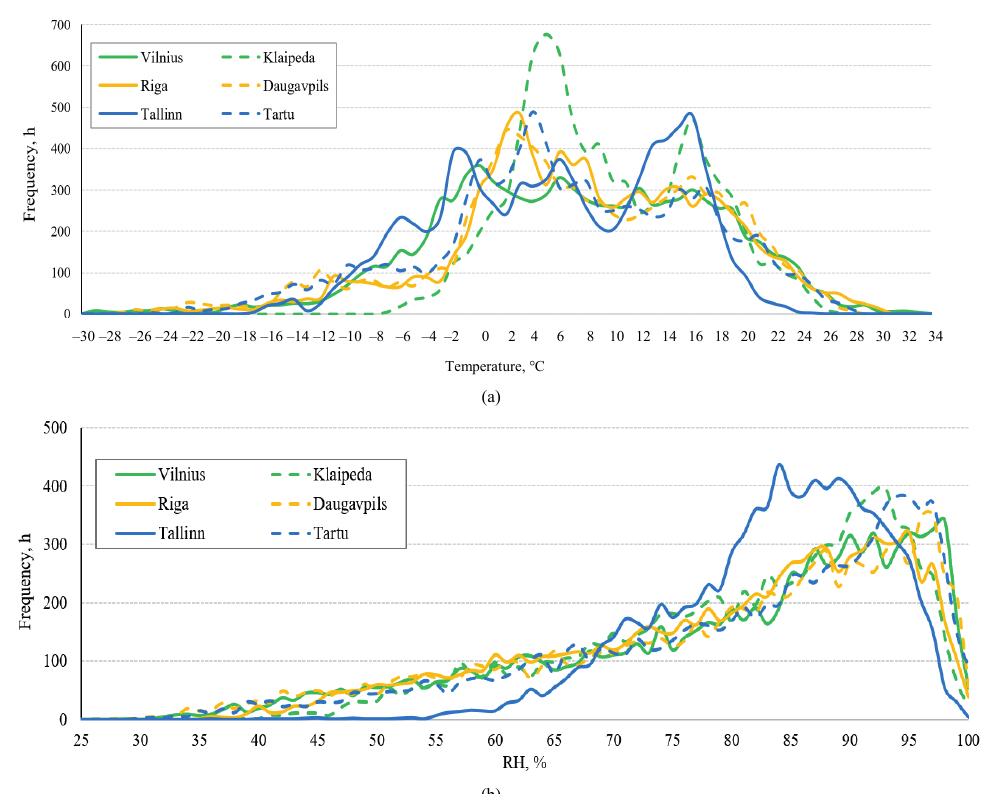
Fig. 4. Hourly distribution: a) air temperature, and b) relative humidity